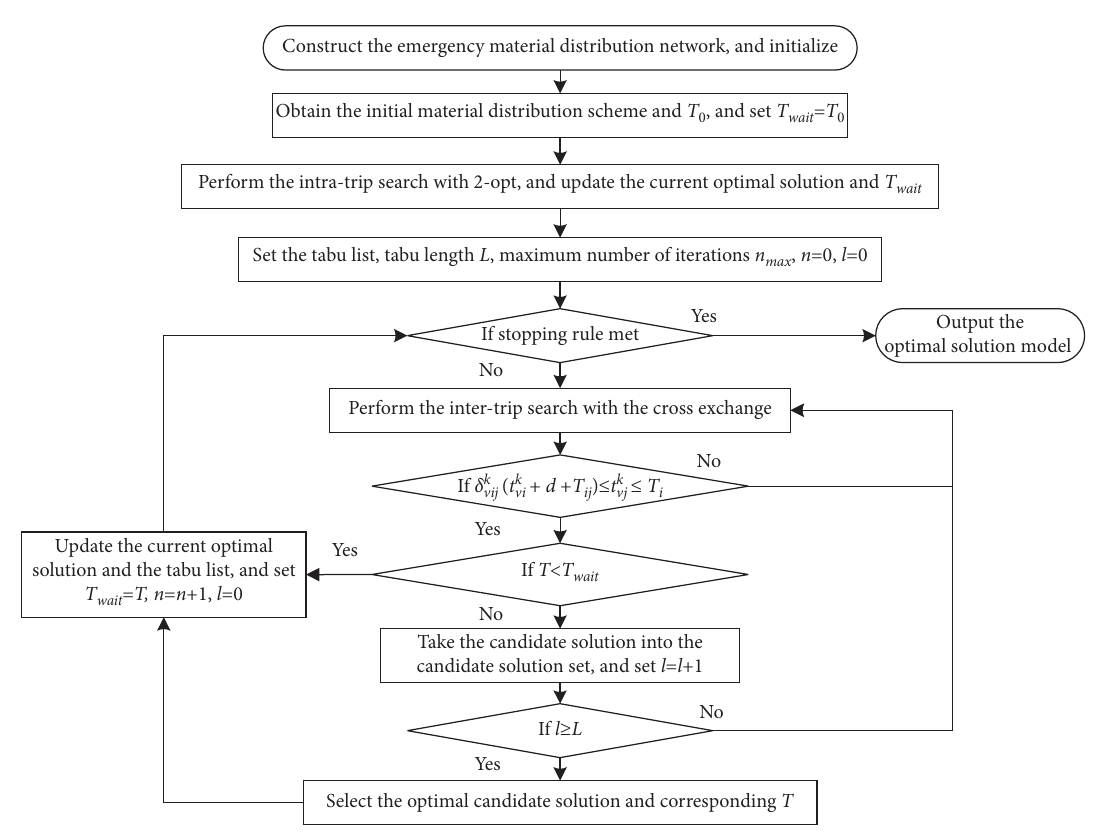
Figure 2: Algorithm flowchart.